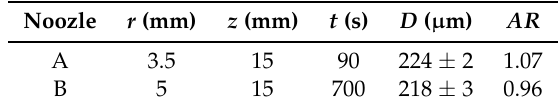
Table 6. Heating conditions and geometrical parameters of the nozzles assembled in the GDVNs devices (Figure 12).